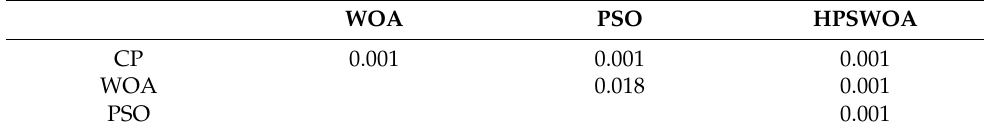
Table 8. Statistical test results for the best total cost obtained from Table